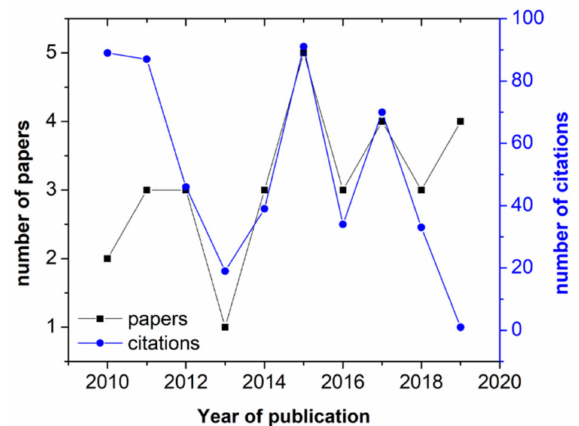
Figure 6. Time distribution of the selected papers along with their citations during 2010–2019 according to a Google Scholar search conducted on 2 April 2020.